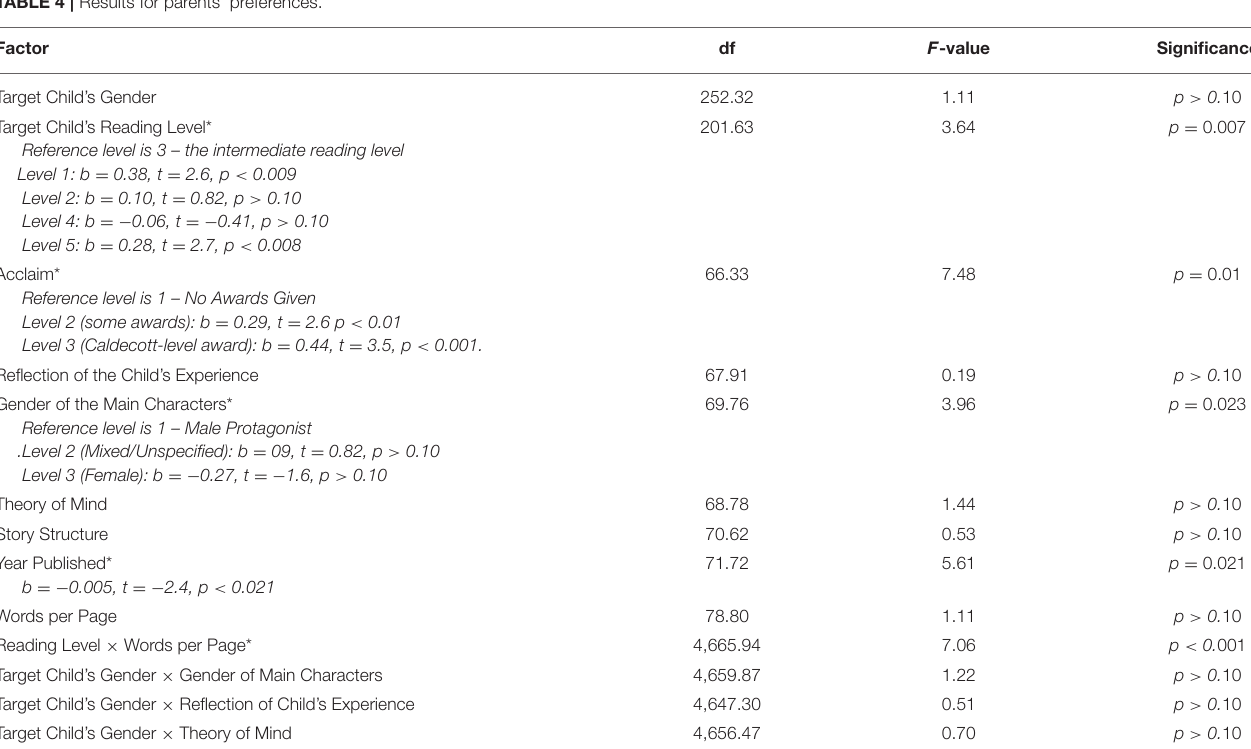
TABLE 4 | Results for parents’